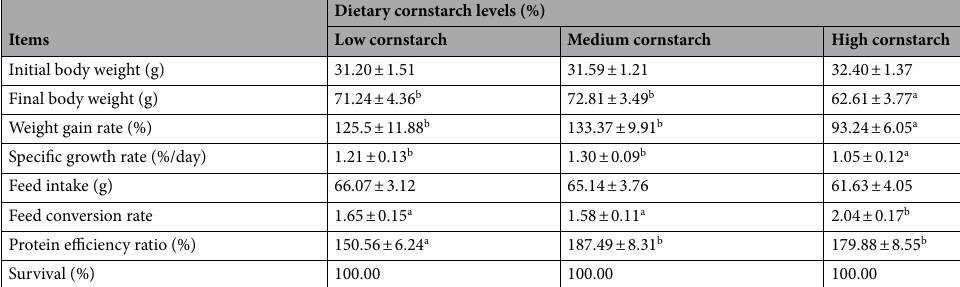
Table 2. Growth performance and feed utilization in GIFT tilapia fed test diets*. *Data represented as mean ± SD of four replicate tanks. Values in the same row with different superscripts are significantly different